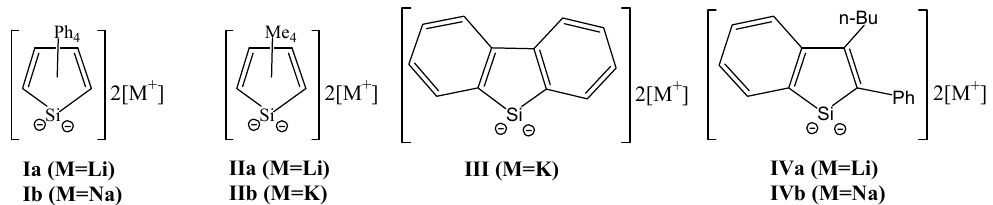
Figure 1. Silole dianions, silafluorenyl dianions, and silaindenyl dianions.